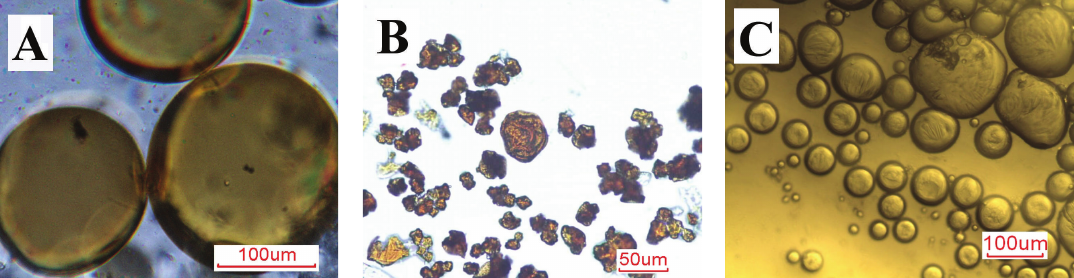
F 2: OM images of the wet magnetic CS microcapsules (A), the microcapsules aer drying in air (B), and the wet SA microcapsules